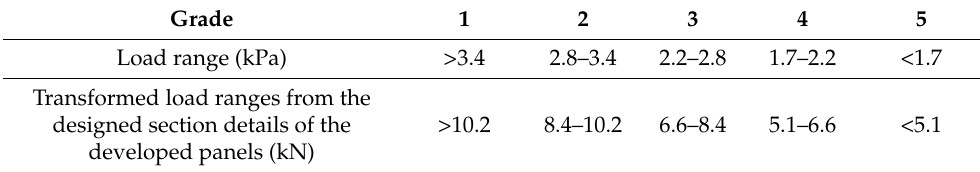
Table 6. Panel classification specified in KS F